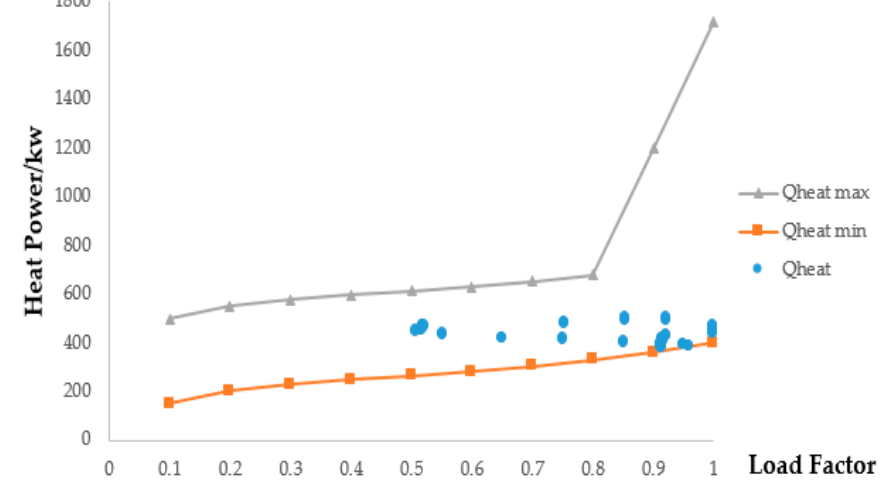
Figure 12. Multi-time scale heat load-load rate operation.